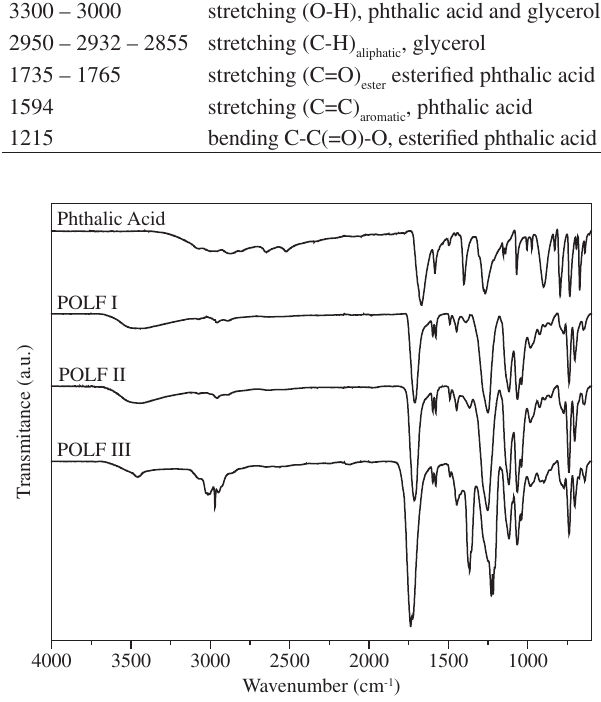
Figure 2. Fourier-transform infrared spectra from POLF series.